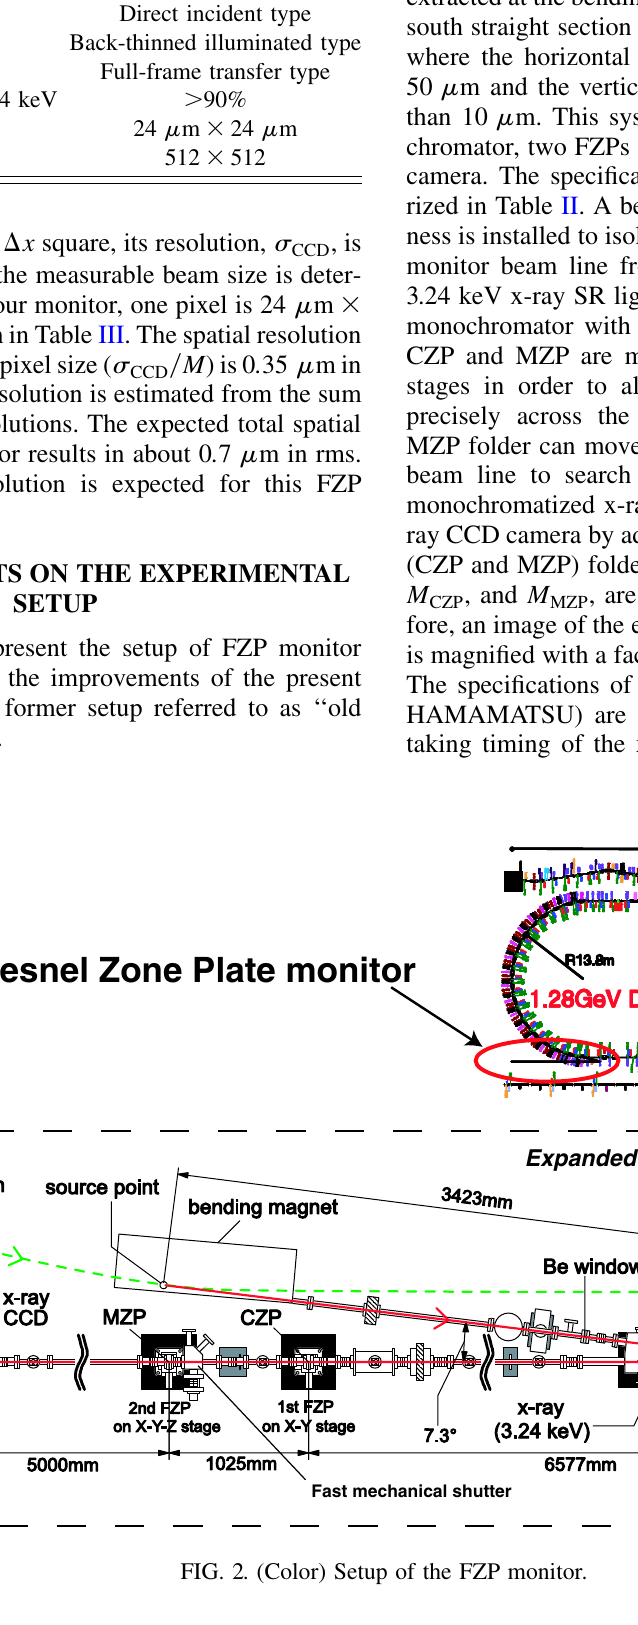
TABLE III. Specifications of the x-ray CCD camera. X-ray CCD